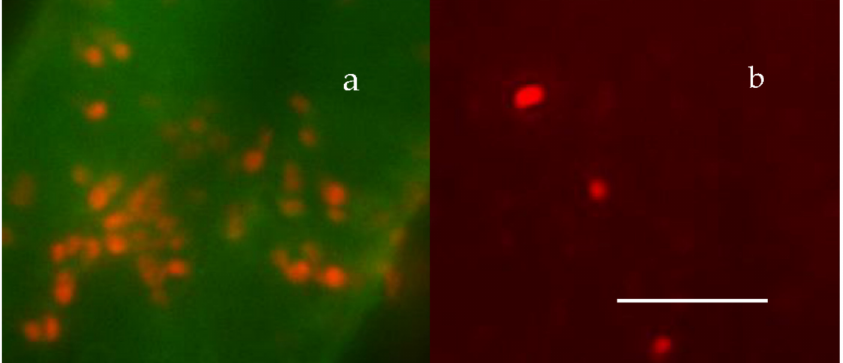
Figure 23. Panel ( a ) shows ~20 MB—labeled with BacLigh-Red TM , found inside an ~100 µ m 2 by 300 nm deep thin section of a MG, labeled with CTC. Panel ( b ) illustrates an equivalent field in the same preparation showing free MB—outside the MG—retained on top of the 0.2 µ m pore filter. The bar = 10 µ